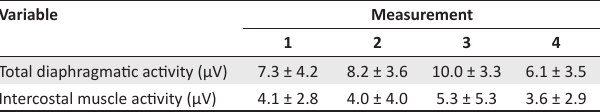
TABLE 3: Surface electromyographic readings at different measurement